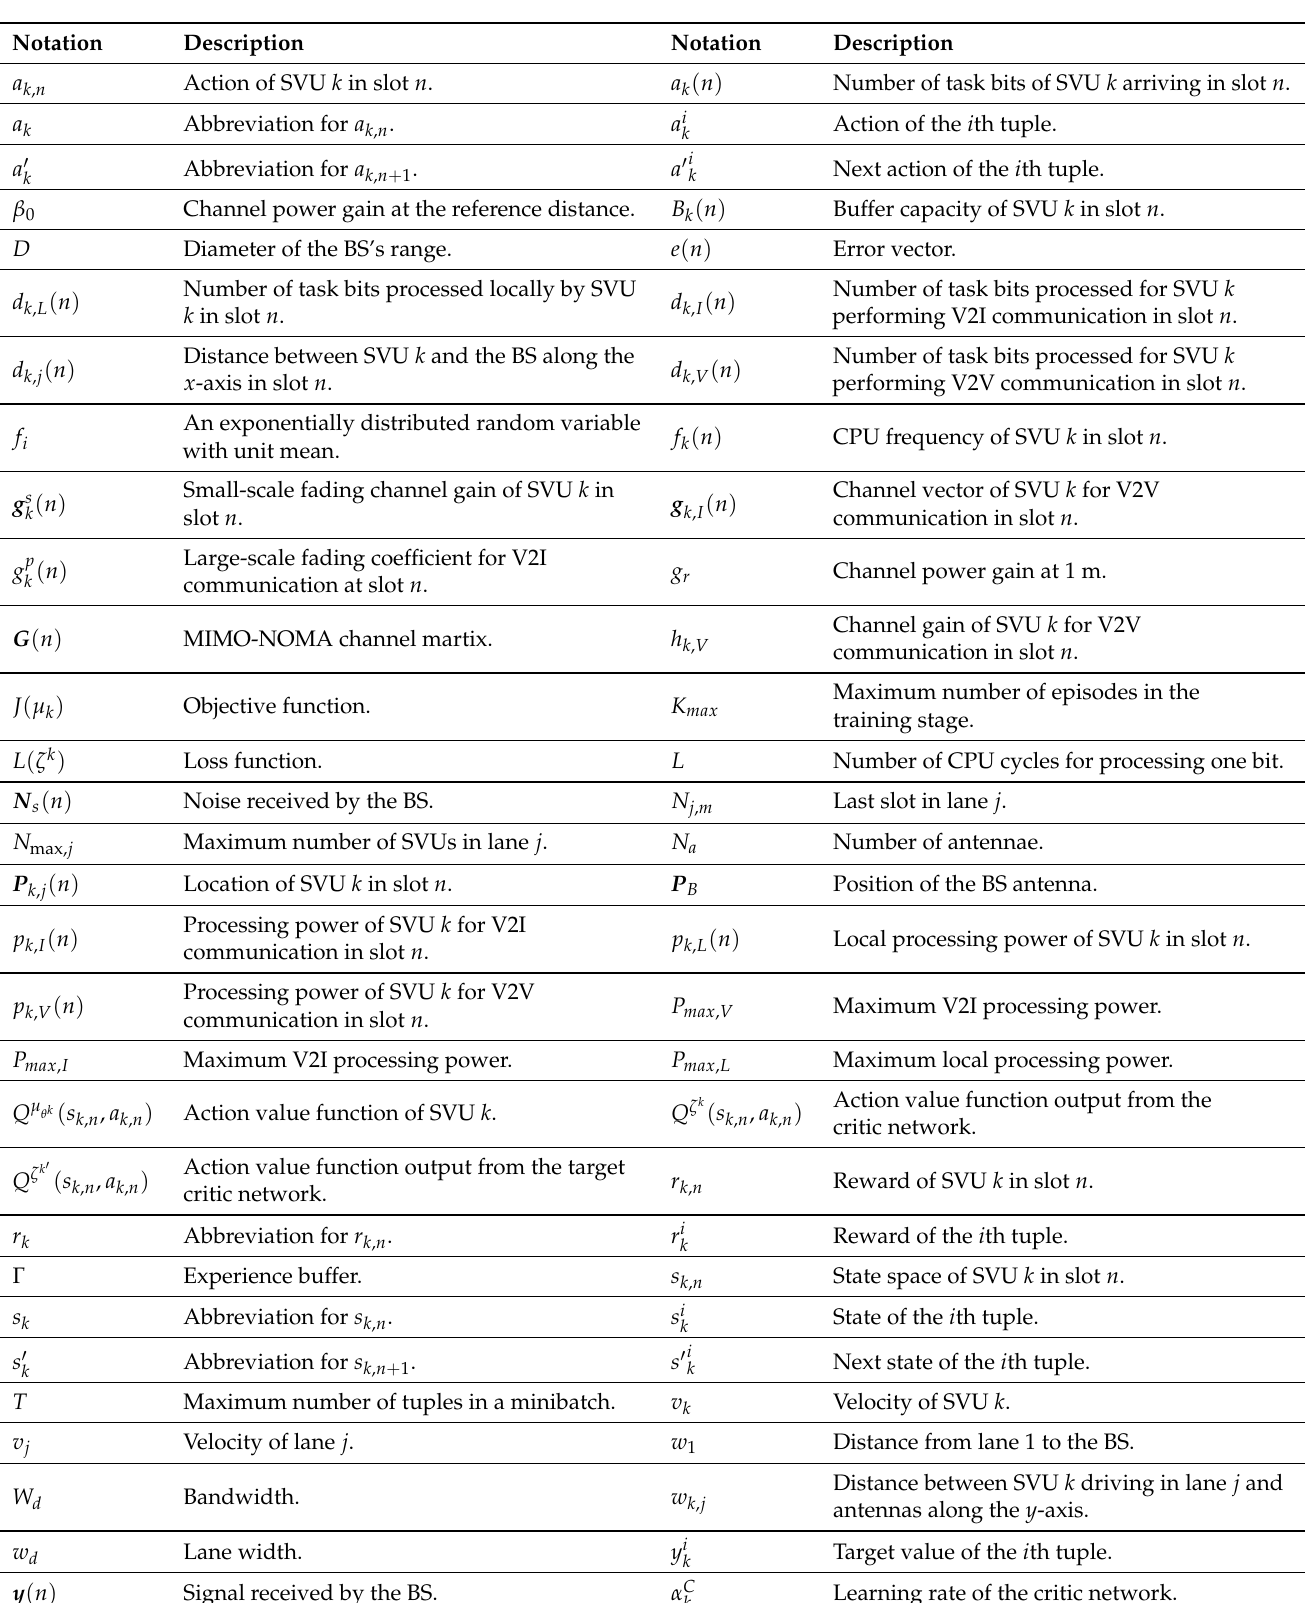
Table 1. Notations used in this